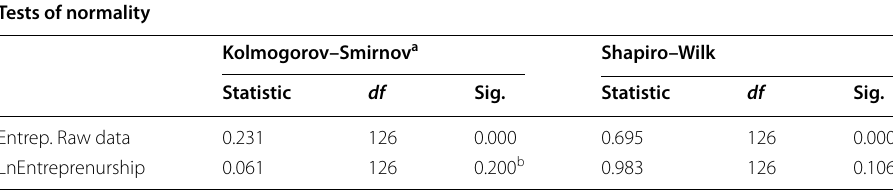
Table 2 Normality test Tests of normality